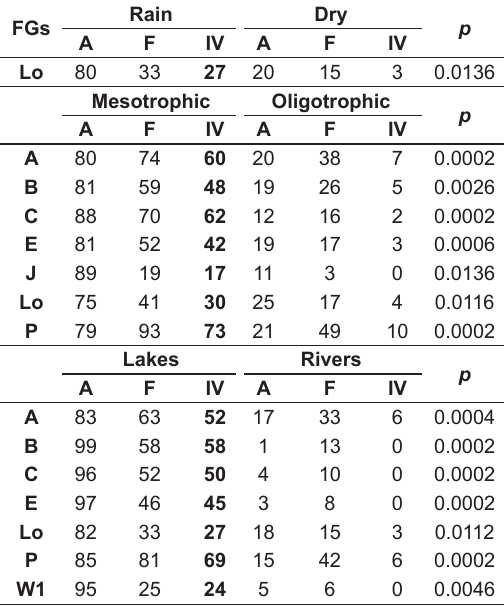
Table 2. Phytoplankton FGs indicators of hydrological periods (Rain and Dry), environment type (river and lake), and trophic state (Oligotrophic and